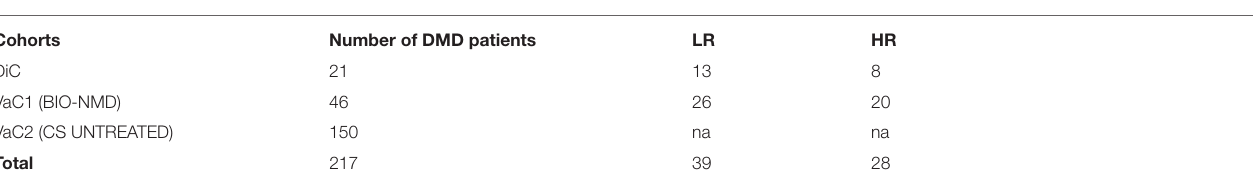
TABLE 1 | Patients’ cohorts